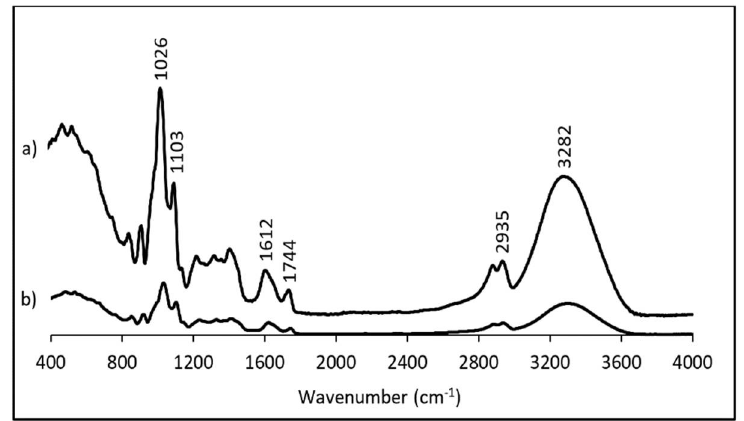
Figure 2. FTIR spectra: ( a ) control film; ( b ) film with S. ramosissima .